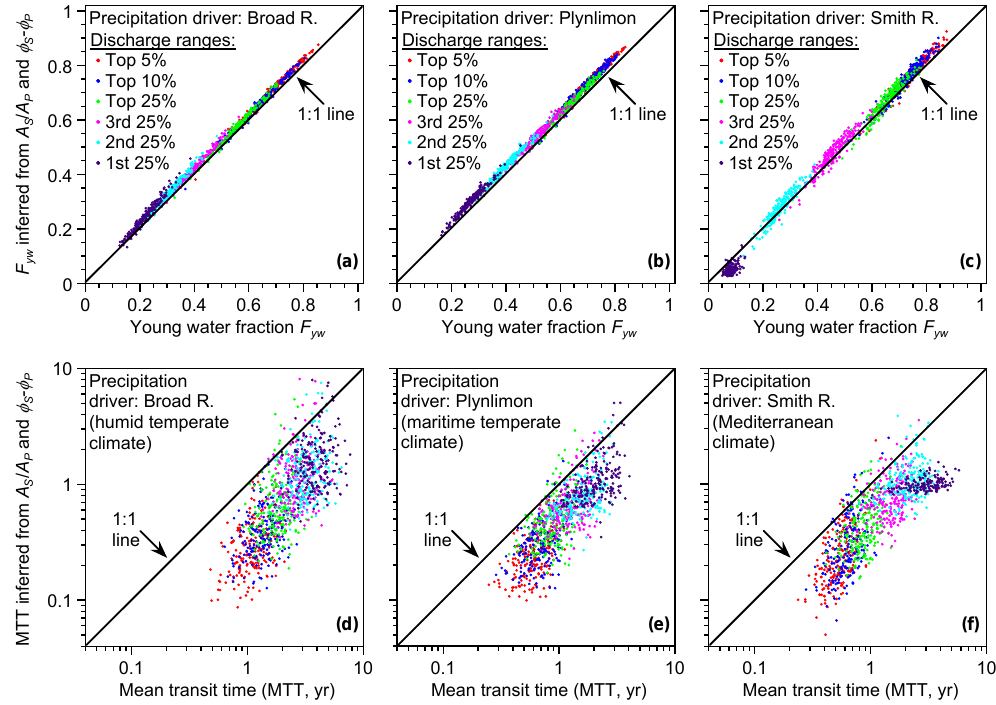
Figure 12. Actual and inferred young water fractions ( F yw , top panels) and MTTs (bottom panels) in separate discharge ranges, under combined effects of nonstationarity and spatial heterogeneity. Panels show results for 200 synthetic catchments, each consisting of eight copies of the two-box model with independent random parameter sets (Fig. 11). Upper panels compare average F yw values with F yw values predicted from amplitudes and phases of best-fit tracer cycle sinusoids for each discharge range (e.g., Fig. 8) using Eqs. (10), (11) and (13), (14) of Paper 1. Similar results (not shown) are also obtained for flow-weighted F yw values and flow-weighted tracer cycle sinusoids. Results obtained from tracer cycle amplitude alone (without phase information) are also similar but exhibit slightly greater bias. Lower panels compare MTT with MTT predicted from tracer amplitude ratios and phase shifts using Eqs. (10) and (11) from Paper 1. Seasonal tracer cycle amplitudes and phases accurately predict young water fractions in separate flow regimes; the corresponding estimates of mean transit times exhibit substantial bias and scatter. show the average concentrations in each discharge range, as functions of the logarithm of discharge. The middle panels show the same concentrations as functions of the inferred F yw , with the vertical axis at F yw = 0 indicating the hypothet- ical old water end-member. The right-hand panels show the concentrations plotted against the reciprocal of F yw ; here, the vertical axis at 1 /F yw = 1 indicates the hypothetical young water end-member. The gray lines are fitted by hand to in- dicate general trends, and to suggest potential end-member